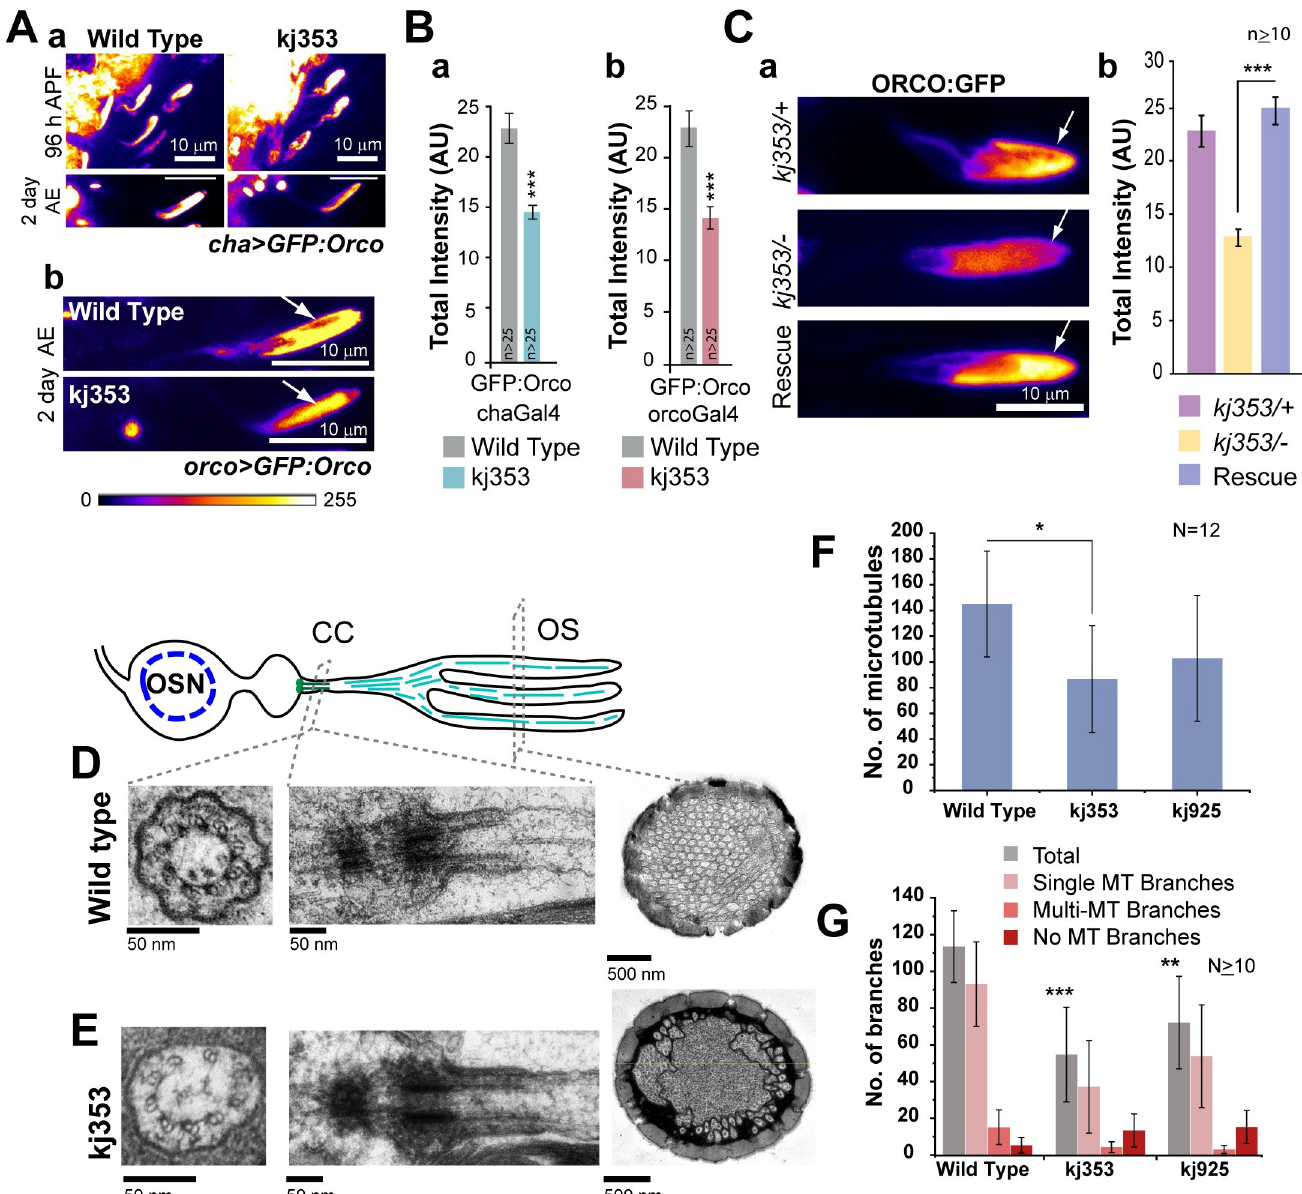
Fig 3. Mutations in the Klp64D gene reduced Orco localisation in the adult olfactory cilia. (A) GFP:Orco localisation in cilia of s . basiconica (arrow), in 96-h APF and two-day-old control and homozygous Klp64D kj353 mutant antennae. The GFP:Orco transgene was separately expressed using chaGal4 (a) and orcoGal4 (b) to test the effects of different levels of recombinant protein expression on its cilia localisation. (B) Total fluorescence intensity of GFP:Orco, driven by chaGal4 (a) and orcoGal4 (b) in the cilia of s . basiconica of two-days-old control and homozygous Klp64D kj353 mutant adults. (C) GFP:Orco localisation in the ciliary OS of control ( chaGal4 > UAS-GFP : Orco/+; Klp64D kj353 /+), hemizygous kj353 ( chaGal4 > UAS-GFP : Orco/+; kj353/Klp64D k1 ) and rescued ( chaGal4 > UAS-GFP : Orco/ UAS-KLP64D-TevHis; Klp64D kj353 /Klp64D k1 ) adults (a). Total fluorescence intensity (mean ± S.D.) measured in the different genetic backgrounds (b). The pairwise significance of difference was estimated using two-tailed Student’s T-test, p-values ( � p < 0.05, �� p < 0.01, and ��� p < 0.001) are shown on the plots. All Images are shown in a false colour intensity heat map (FIRE, ImageJ), and scale bars indicate 10 μ m. (D-E) Ultrastructure of the basiconic cilia in the wild-type and homozygous Klp64D kj antennae. Schematic illustrates the microtubule organisation in cilia inside s . basiconica . TEM images of sections through the basal bodies, connecting cilia (CC) and outer segments (OS) of cilia inside s . basiconica from one-day-old wild-type (D) and homozygous kj353 (E) antennae. F, G) Histograms describe the total number of singlet MTs (F) and the distribution of different types of branches (G) found in the OS in wild type and the mutants. The pairwise significance of difference was estimated using one-way ANOVA test, p-values ( � p < 0.05, �� p < 0.01, and ��� p < 0.001) are shown on the plots. Error bars represent as ± S. D. The n values indicate number of sensilla in panels B and C, and the N values in panel F indicate number of TEM sections obtained from at least 3 different heads.